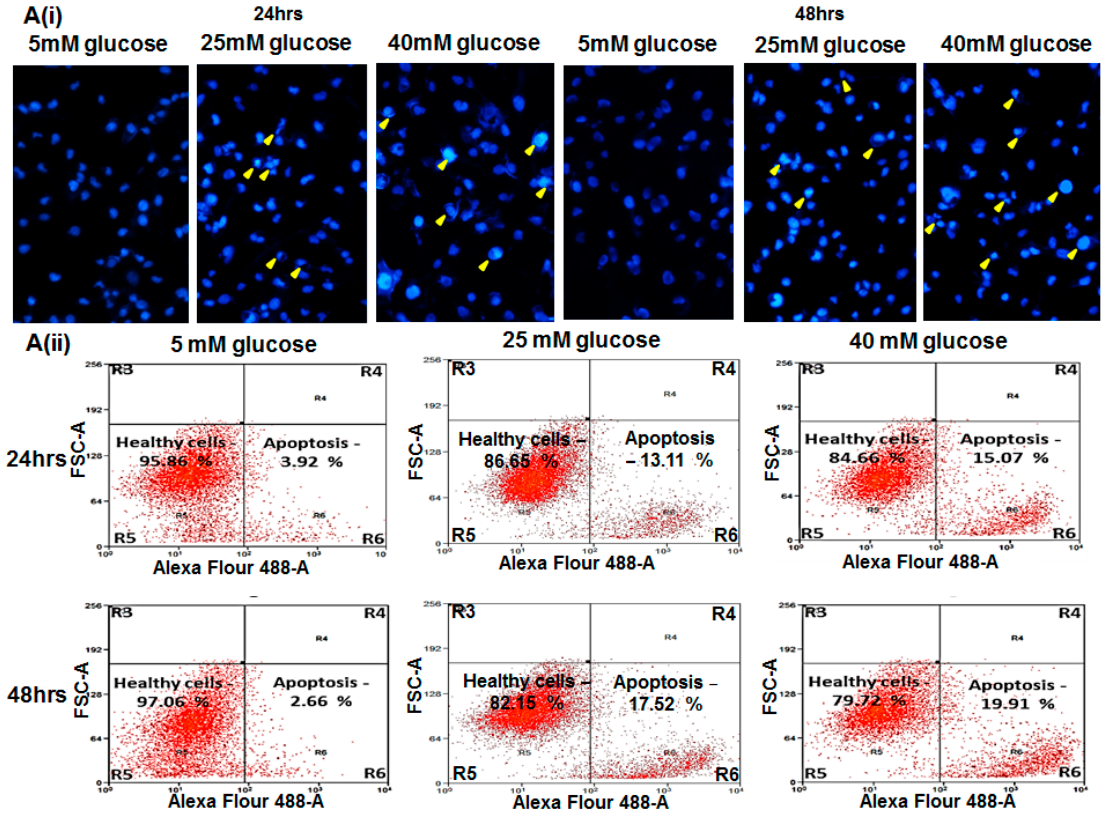
Figure 2. Cont. Figure 2.